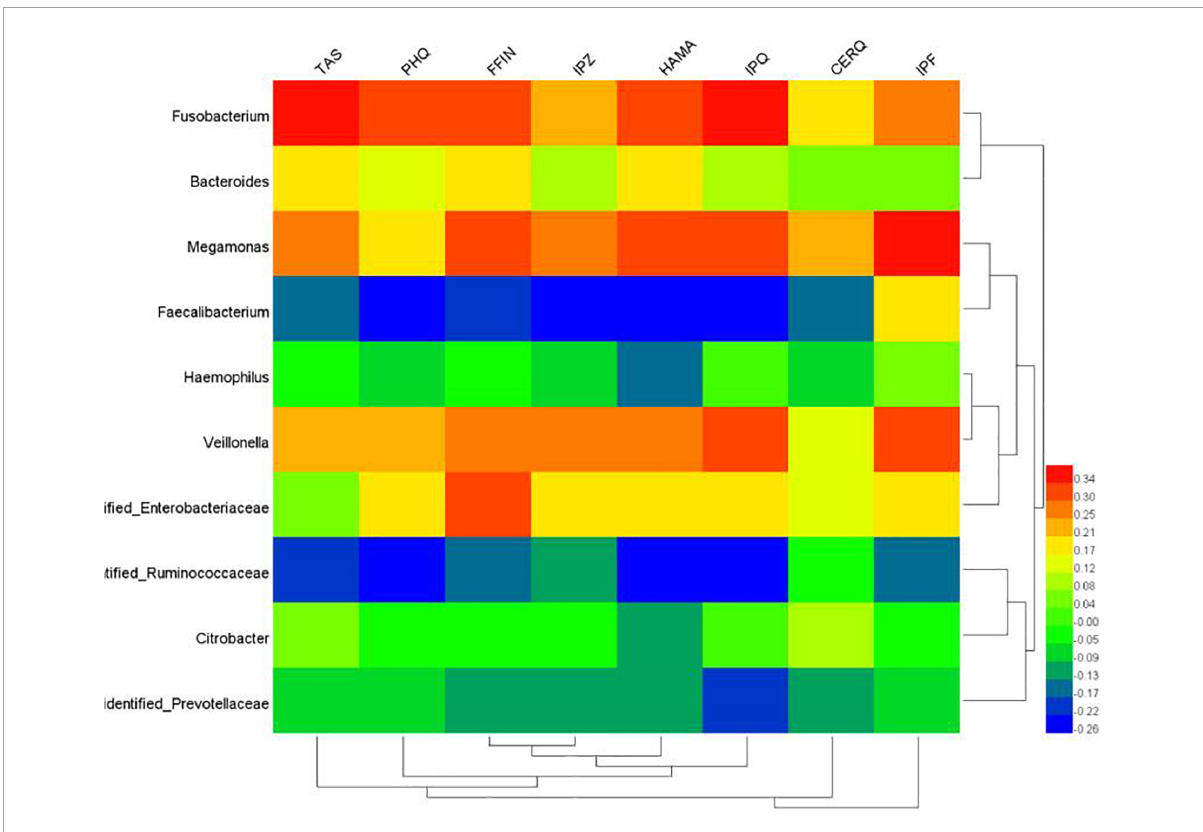
FIGURE6 Heat map of correlation analysis between psychosocial factors and intestinal